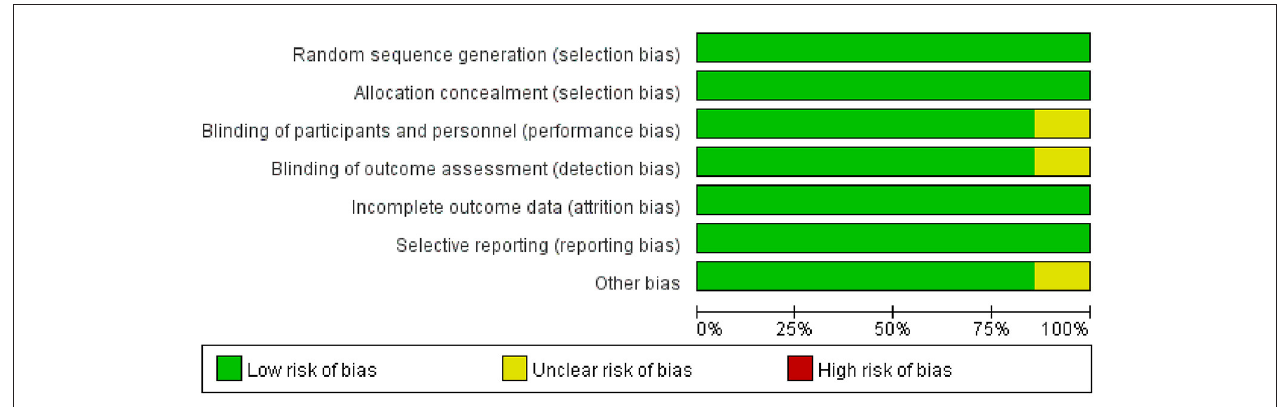
FIGURE 2 | The risk of bias graph of included